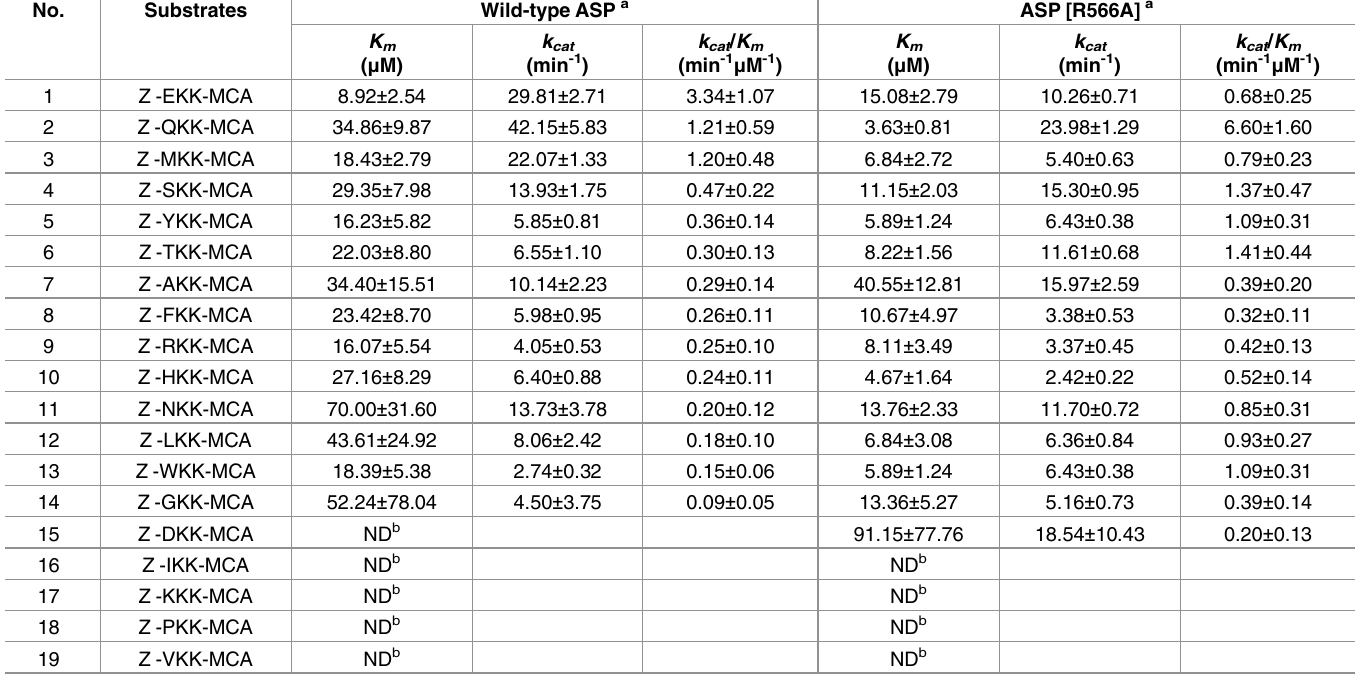
Table 2. Kinetic constants in the hydrolysis of synthetic substrates by wild-type ASP and the mutant ASP[R566A].